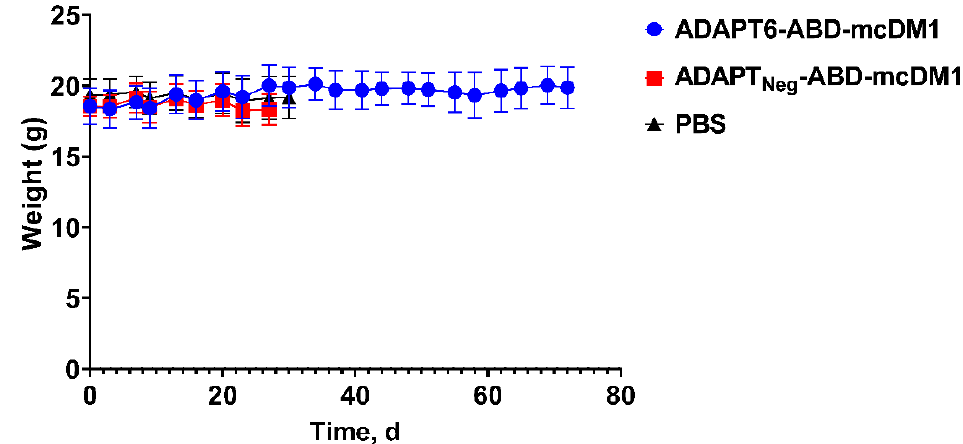
Figure 4. Average animal weight in each group during the therapy experiment. The data are presented as an average value ± SD. The curves were drawn until 30–33% of the mice in a group were euthanized.